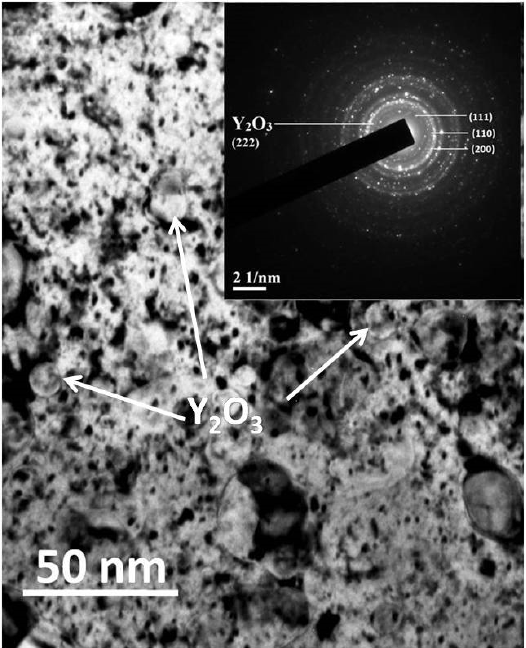
Fig.6 TEM images of alloy B powder sample after 40 h of mechanical milling